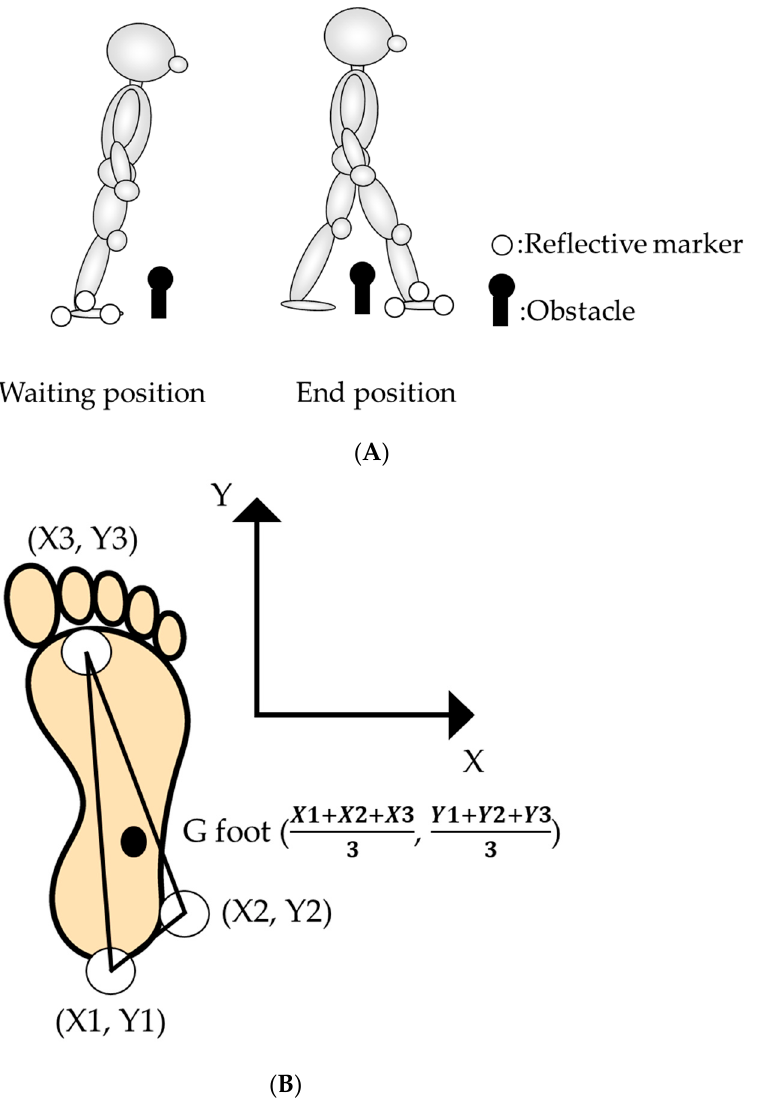
Figure 3. ( A ). The participants’ waiting and end positions. ( B ). Reflective marker coordinates of the swing foot (G foot).